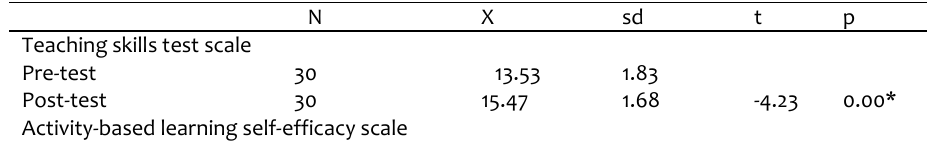
Table 2. Teachers’ Answers and Results of t-test in Pre-test and Post-test